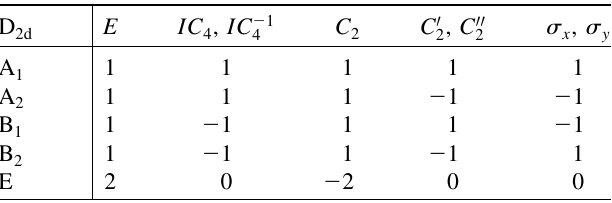
TABLE XII. Character table for the point group D